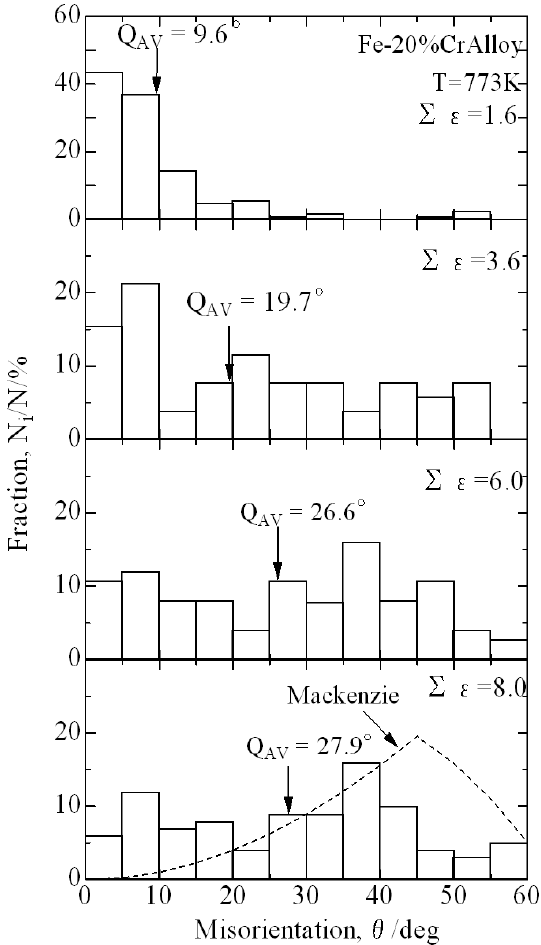
Figure 6. Misorientation distribution of grain/subgrain boundaries in a Fe-20%Cr steel subjected to multiple forging at 773 K to various total strains. Reproduced from [60], with permission from Springer Nature, 2023.